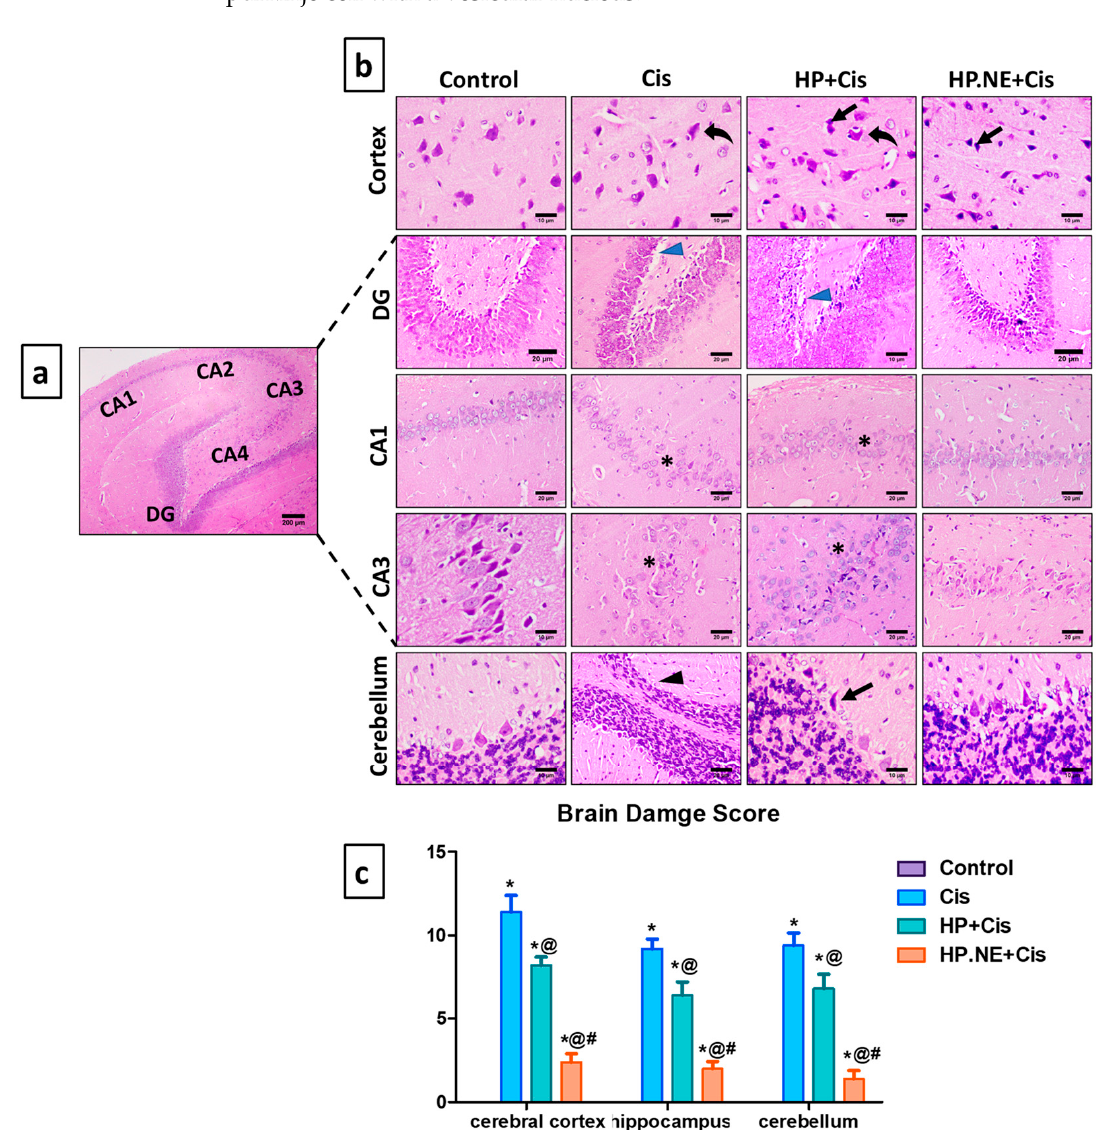
Figure 7. Effect of HP L. and HP.NE administration on the histological structure of the brain. ( a ) Photomicrograph from control group presenting the normal structure of the hippocampal area, which is made up of Cornu Ammonis (CA1, CA2, CA3, and CA4) and Dentate gyrus (DG); scale bar denotes 200 µ m. ( b ) Photomicrograph of brain tissues stained with H&E; scale bars denote 10 and 20 µ m. Notable symbols on the figure point to neurophagia of degenerated neurons (curved arrows), dark stained neurons (arrows), loss of neurons (black arrowheads), areas void from neurons (*), and vacuolation (blue arrowheads). ( c ) Brain damage score. Results are expressed as median ± standard deviation (SD), determined using the Kruskal–Wallis test followed by Dunn’s multiple comparison test. * means significant from the control group; @, significant from the Cis group; and #, significant from HP + Cis group.